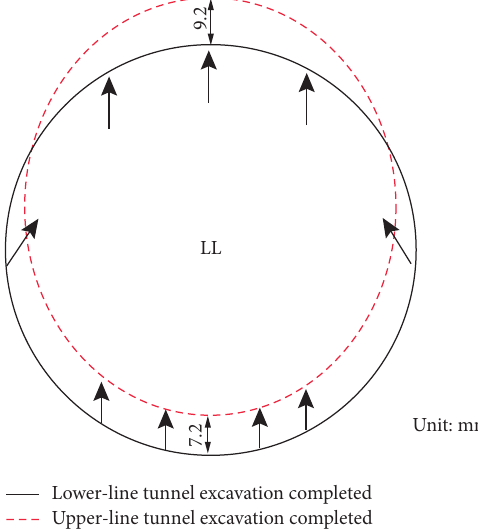
Figure 13: The lining deformation of the lower-line